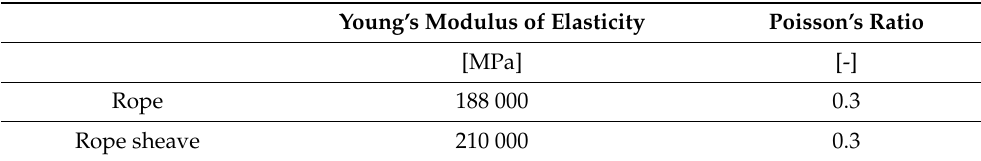
Table 11. Material parameters for contact surfaces (i.e., for rope and rope sheave).